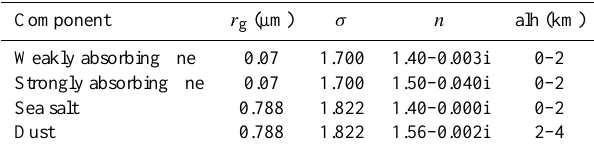
Table 1. Properties of the aerosol components used in this work (de Leeuw et al., 2015). Listed are the geometric radius r g , standard deviation σ , refractive index n at the wavelength of 0.555µm, and the aerosol layer height